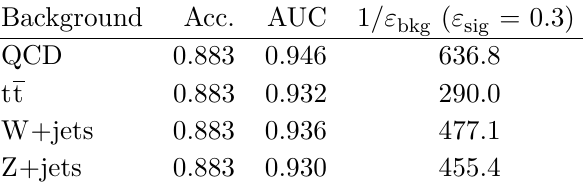
Table 3 . Metrics representing the performance of the BDT for the benchmark signal model ( m = 3 . 1 TeV, m = 20 GeV, r = 0 . 3 , α = α peak ), compared to each of the major SM dark inv dark dark Z 0 background